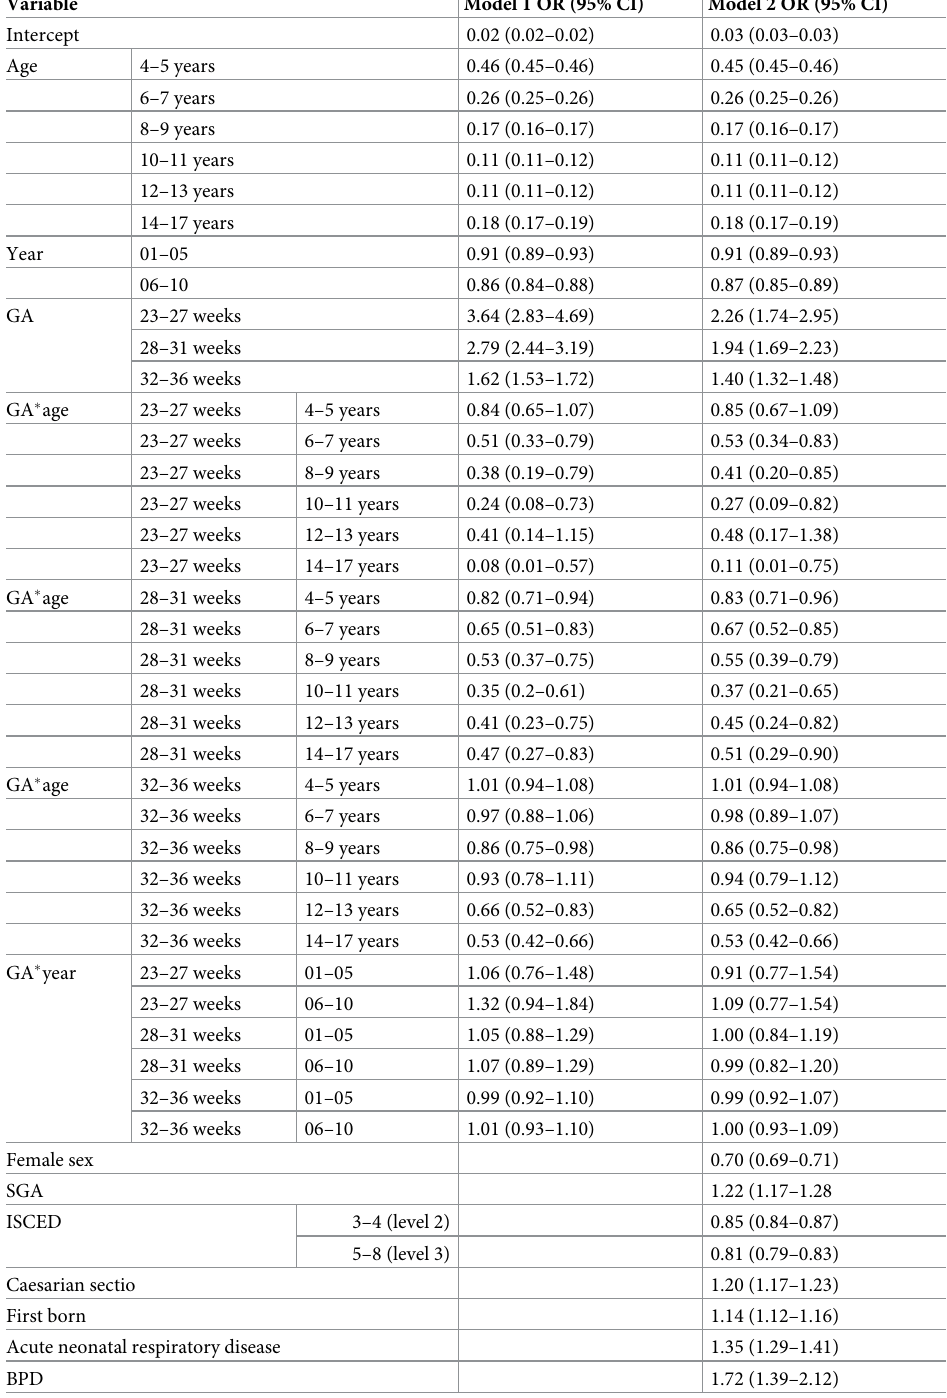
Table 4. Odds ratios for admission to